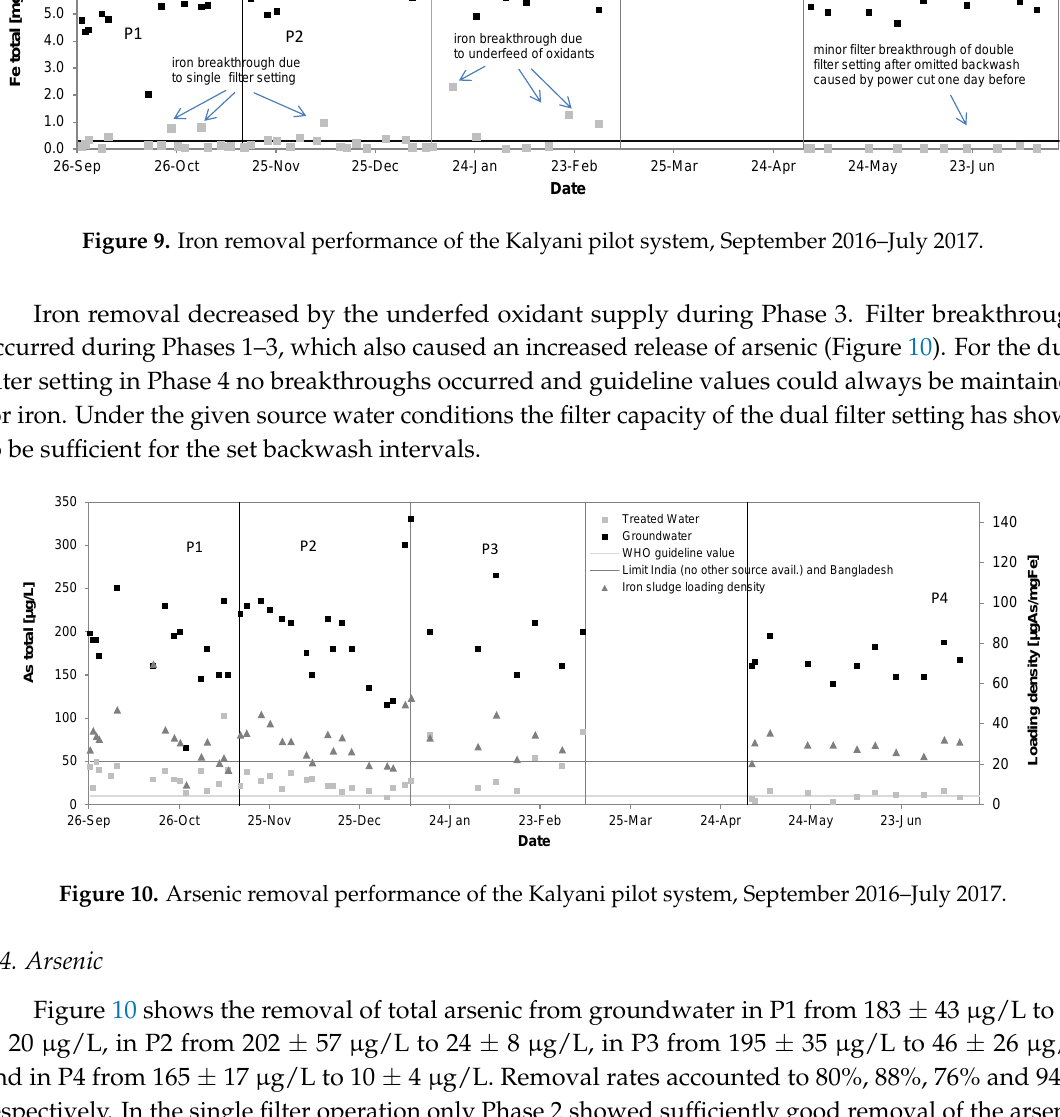
Figure 9. Iron removal performance of the Kalyani pilot system, September 2016–July 2017.